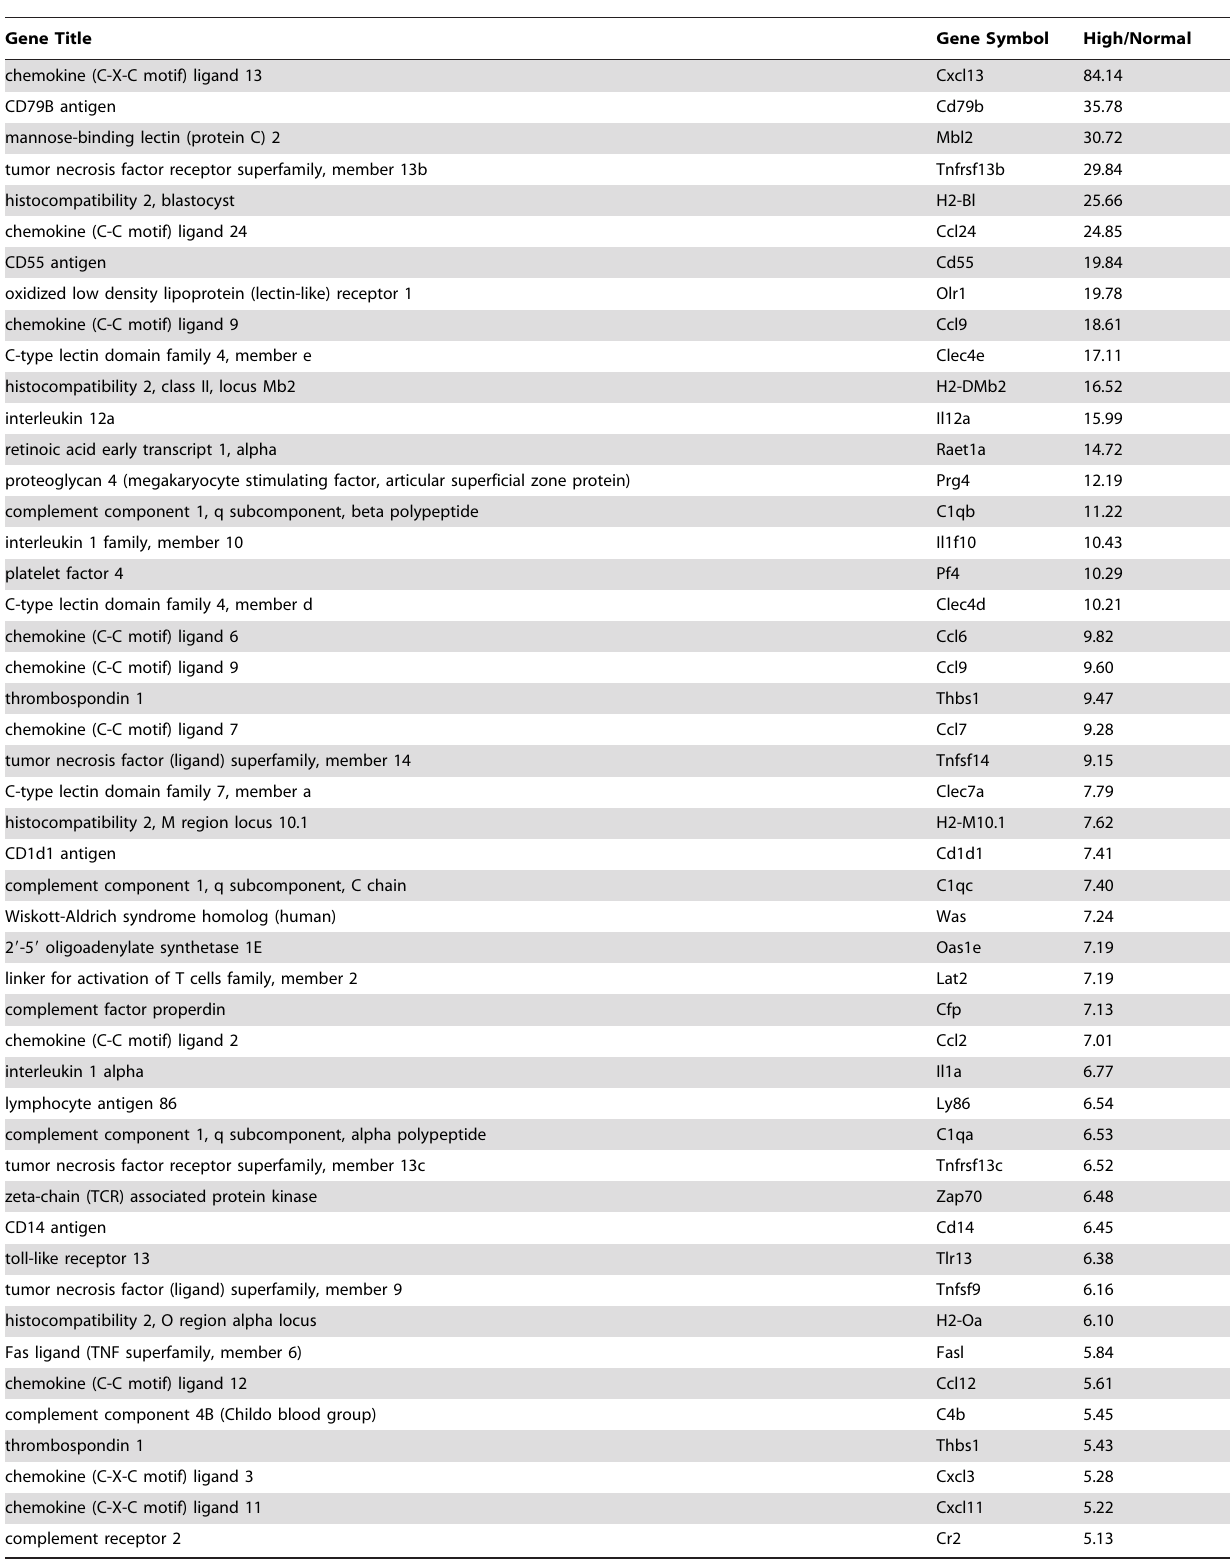
Table 4. Upregulated genes ( . 5-fold) classified as ‘inflammatory response